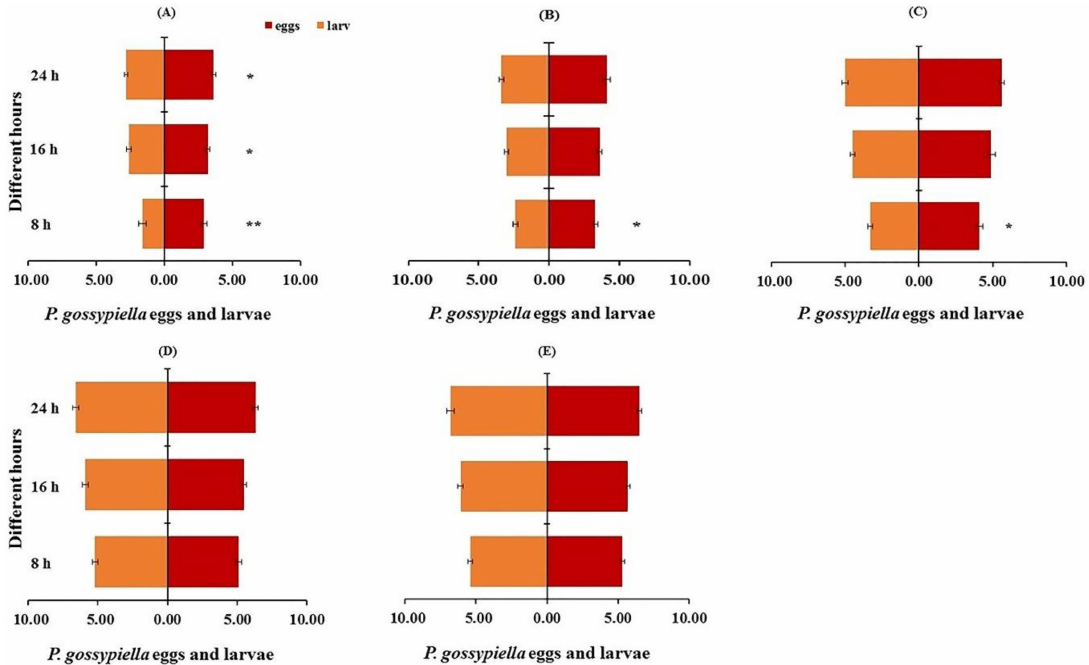
Figure 8. Prey preference between P. gossypiella eggs and first instar larvae (10 each) of the predatory stages of O. strigicollis during 8 h, 16 h and 24 h treatment using paired t -test, n = 10, * p < 0.05, ** p < 0.01, (( A ) = 3rd instar, ( B ) = 4th Instar, ( C ) = 5th Instar, ( D ) = Male, ( E ) =